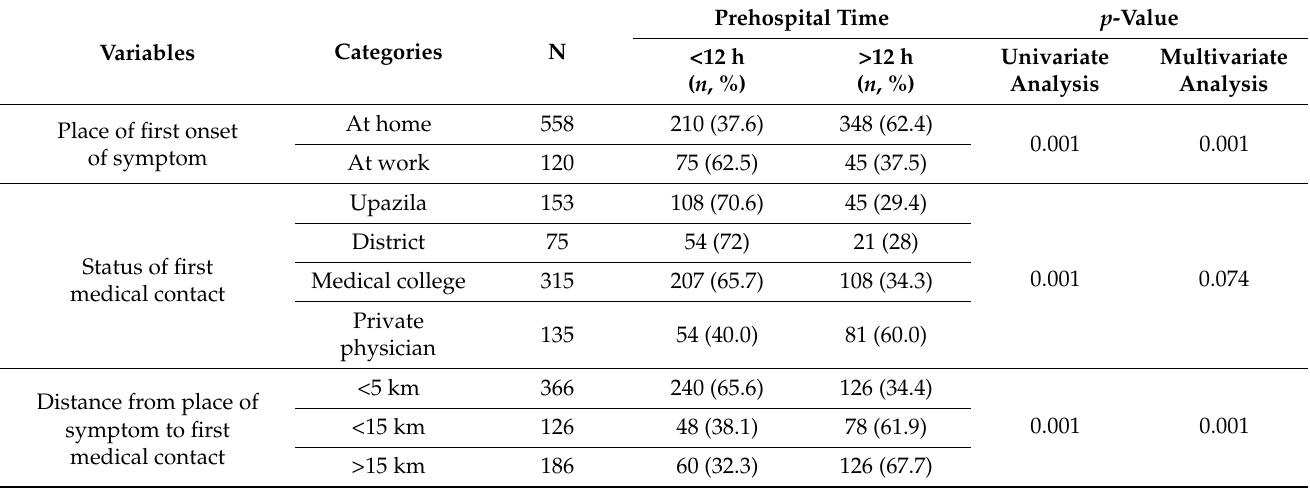
Table 4. Association between different factors and prehospital delay with acute coronary